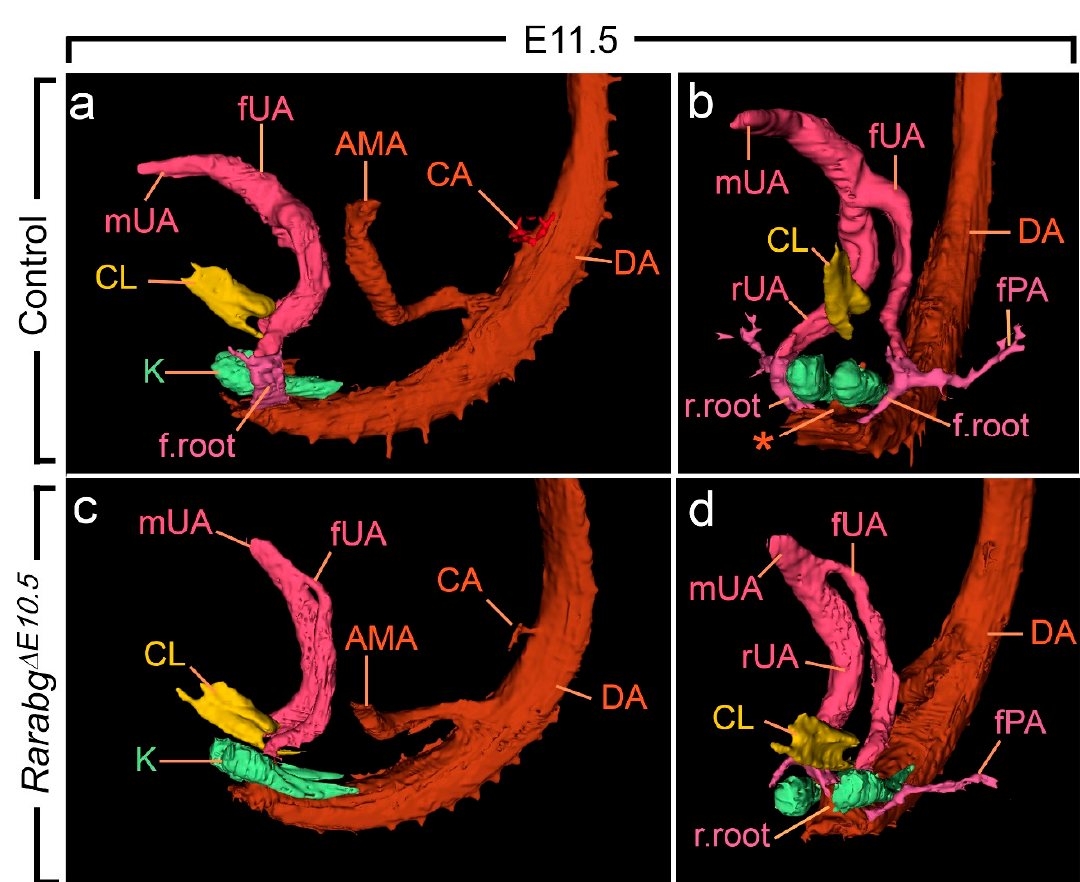
Figure 5. Left lateral ( a , c ) and ventral ( b , d ) views of the cloaca, kidneys and arteries in control and Rarabg Δ E10.5 mutant embryos at E11.5. ( a , b ) In the control, the left and the right umbilical arteries are equal in calibre; their roots have taken a lateral course and bypass the kidneys on each side of the midline; the principal arteries to the hindlimbs arise from their lateral sides. ( c , d ) In the mutant, the umbilical roots still originate from the ventral wall of the aorta and pass medial to the kidneys; the left umbilical artery is hypoplastic and the principal artery to the left hindlimb connects directly to the dorsal aorta. AMA, anterior mesenteric artery; CA, coeliac artery; DA, midline dorsal aorta; CL, lumen of the cloaca; K, metanephric mesenchyme; fPA, left artery to the hindlimb bud; r.root and f.root, roots of the right and left umbilical arteries; rUA, fUA and mUA, right, left and middle umbilical arteries, respectively. The asterisk designates the remnant of the medial umbilical roots. Same magnification in ( a – d